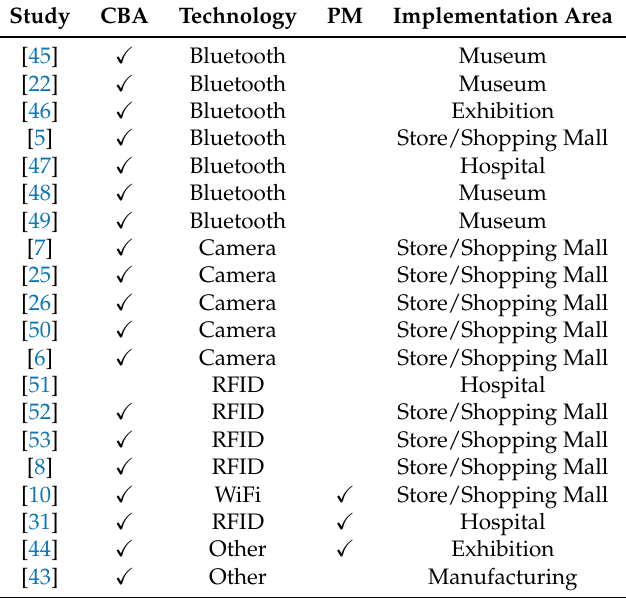
Table 2. Summary of the literature review. CBA, customer behavior analysis; PM, process